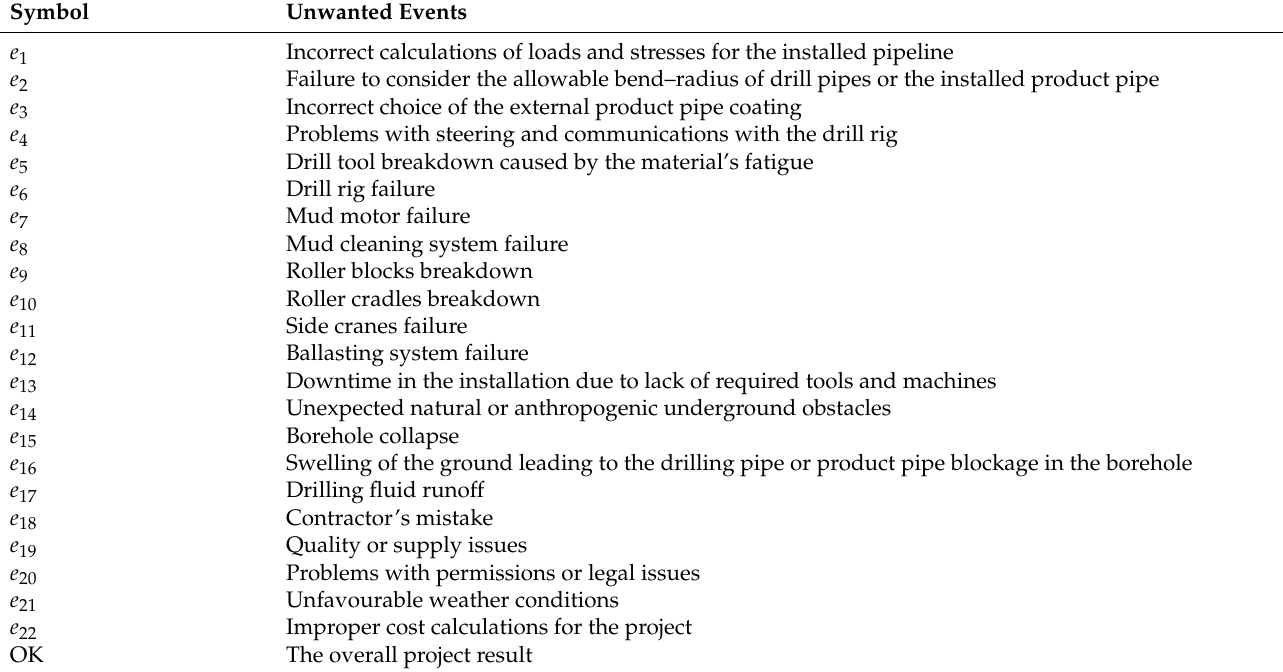
Table 1. The list of unwanted events and their